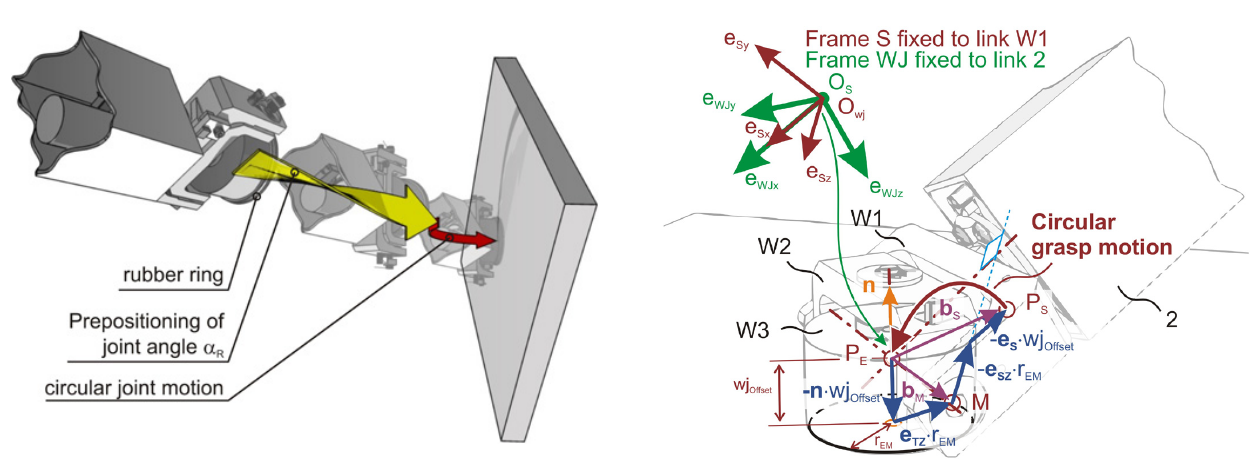
Figure 16. Computation of the circular grasp motion.